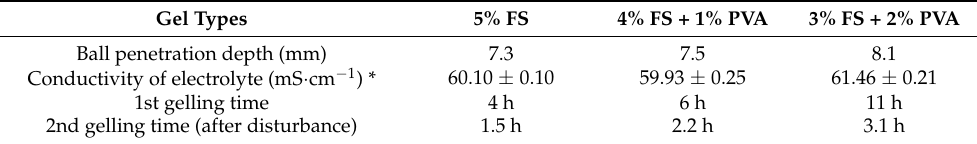
Table 1. Physical characteristics of the PVA-FS gel